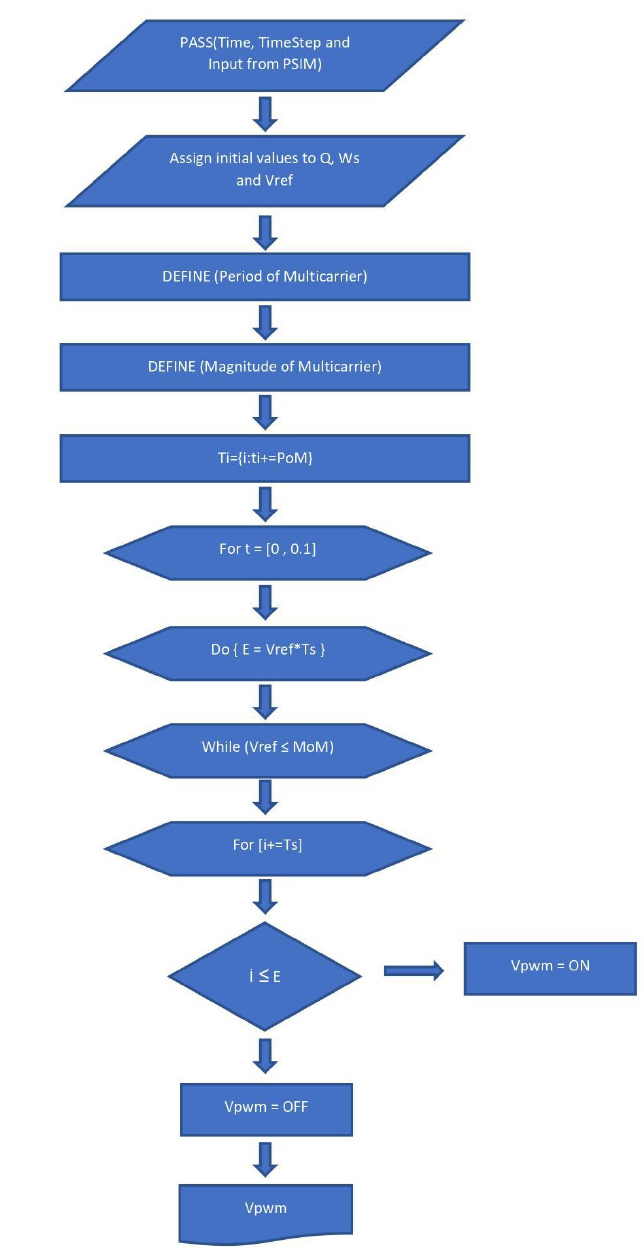
Figure 7. Flow diagram of digital implementation to create PWM